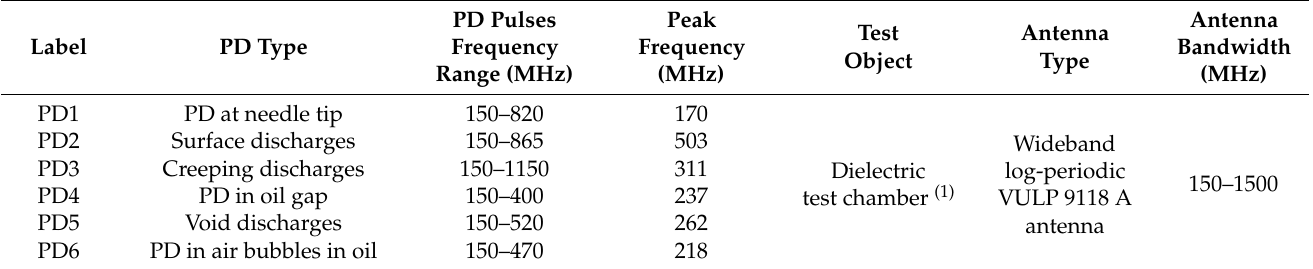
Table 3. Frequency parameters of the investigated types of PDs.